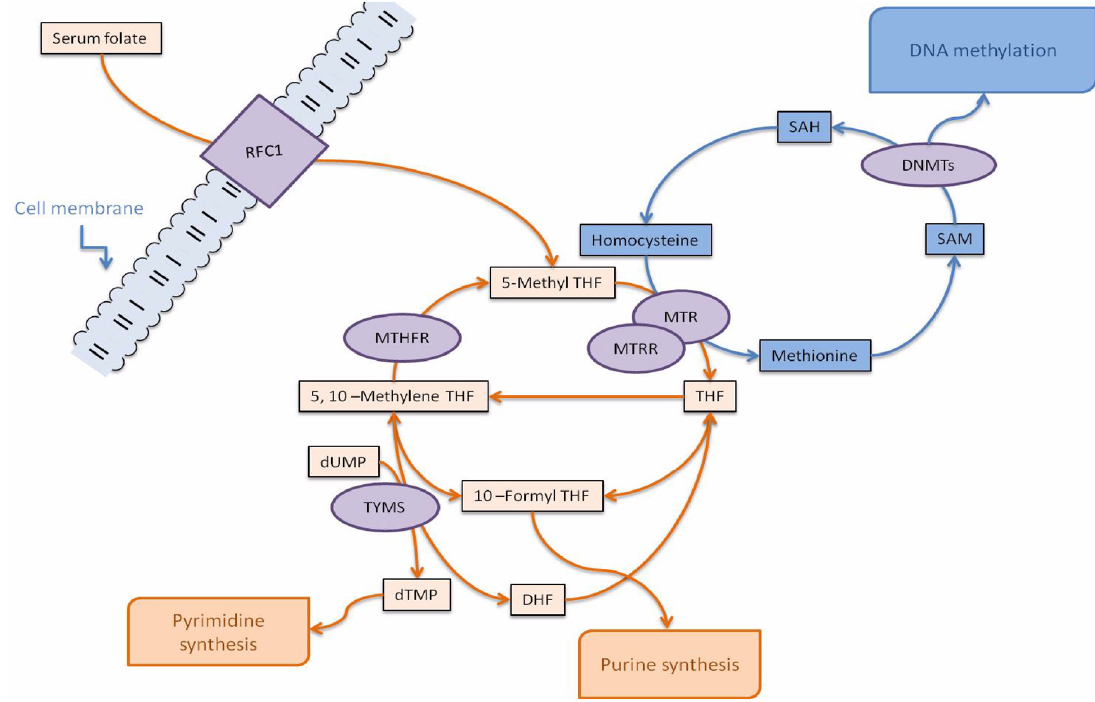
Figure 1. Simplified overview of the folate (orange color) and methionine (blue color) cycles in the one-carbon metabolism, adapted from [1]. The diagram illustrates the enzymes (violet color) whose polymorphisms have been investigated in this article, and their metabolites. Enzymes: DNMTs, DNA methyltransferases; MTHFR, methylenetetrahydrofolate reductase; MTR, methionine synthase; MTRR, methionine synthase reductase; RFC1, reduced folate carrier 1; TYMS, thymidilate synthase. Metabolites: DHF, dihydrofolate; THF, tetrahydrofolate; dTMP, deoxythymidine monophosphate; dUMP, deoxyuridine monophosphate; SAH, S -adenosylhomocysteine; SAM, S -adenosylmethionine.